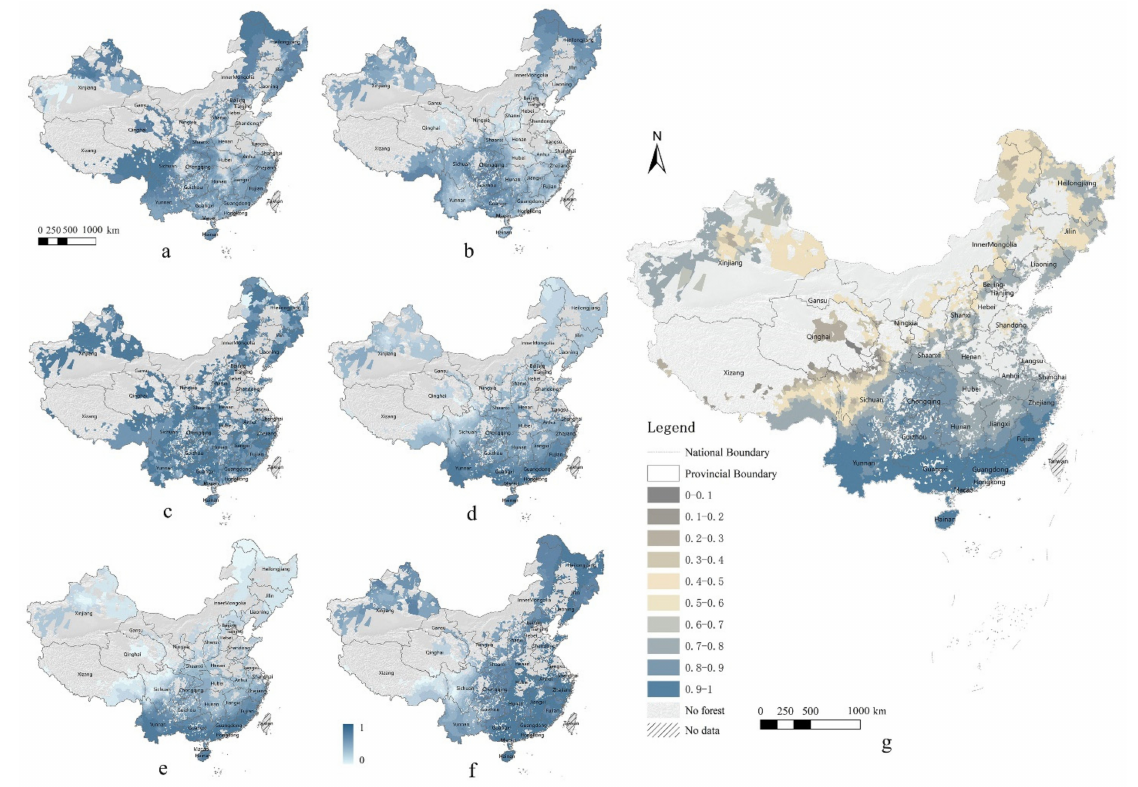
Figure 5. The sustainability evaluation results of the HE dimension. The evaluation results of the ( a ) water quality level, ( b ) altitude, ( c ) PM 2.5 density, ( d ) O 3 density, ( e ) relative humidity, and ( f ) temperature; ( g ) the DI of the HE